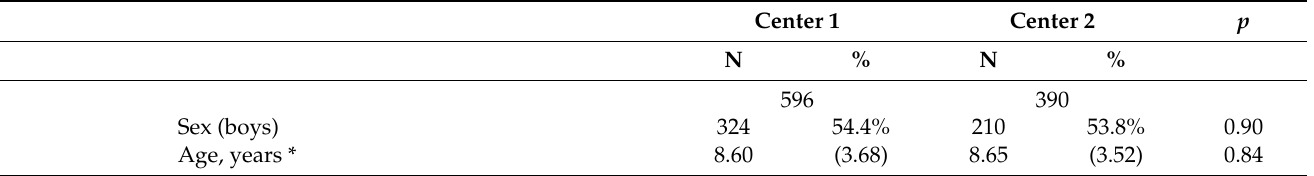
Table 1. Characteristics of the